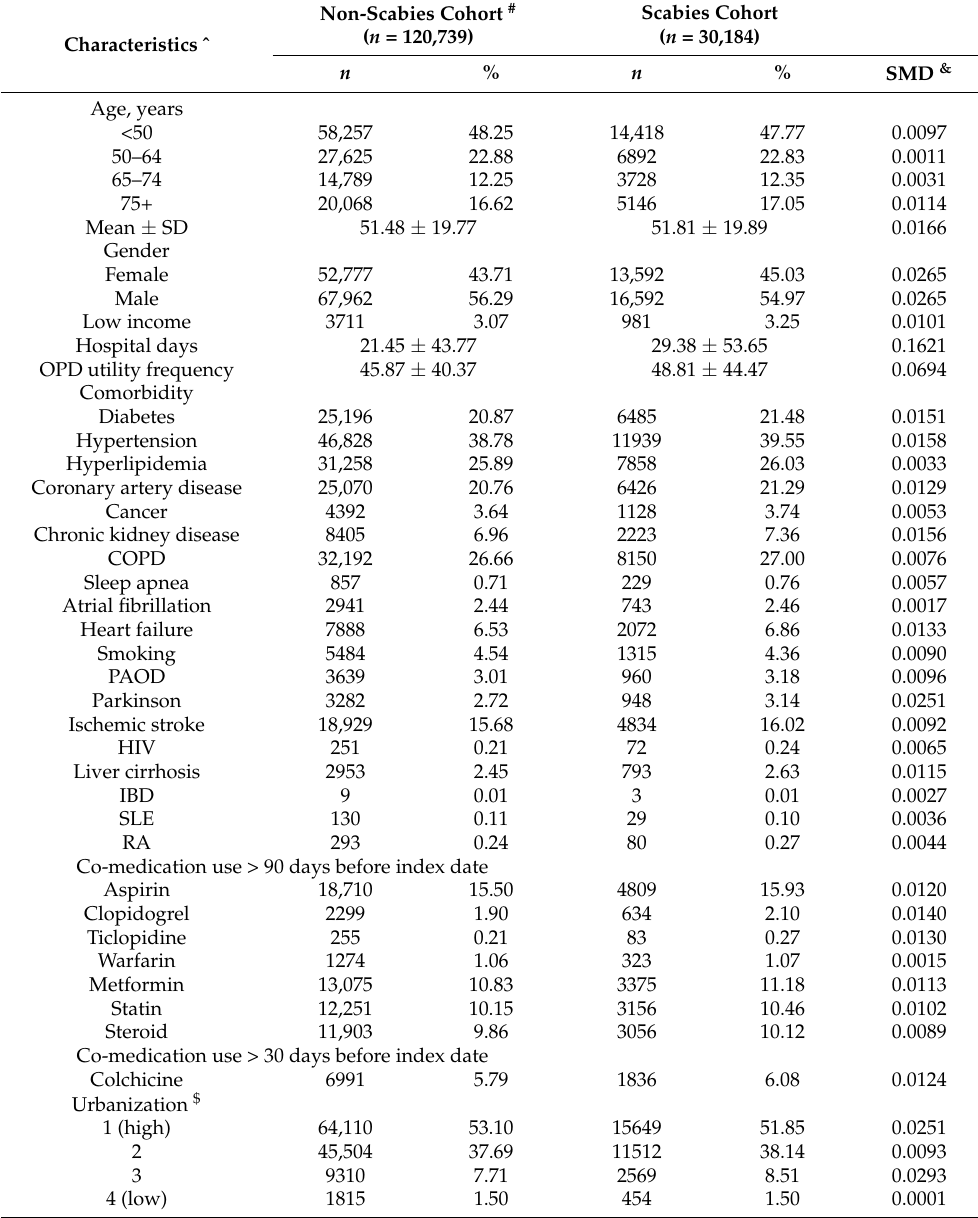
Table 1. Baseline demographic factors, co-morbidities, and medications between scabies and non- scabies cohorts. Non-Scabies Cohort # Scabies Cohort Characteristics